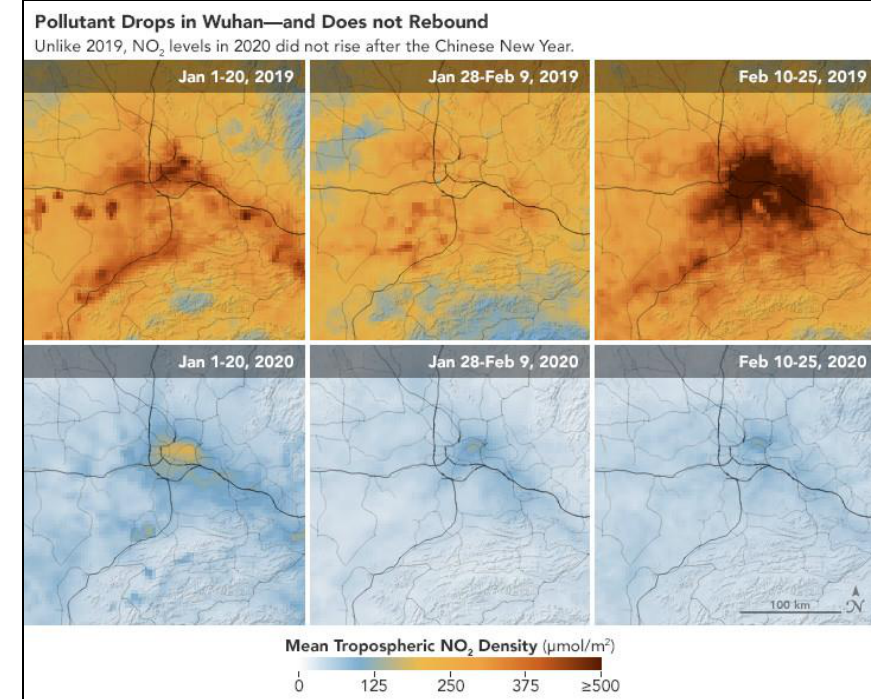
Fig. 12: Levels of nitrogen dioxide over the epicenter of COVID-19 outbreak; Wuhan, China (NASA, 2020). The images of the country before and after the quarantines (from January 1 st to 20 th - top) and (from February 10 th to 25 th - bottom), respectively (The Verge, 2020)